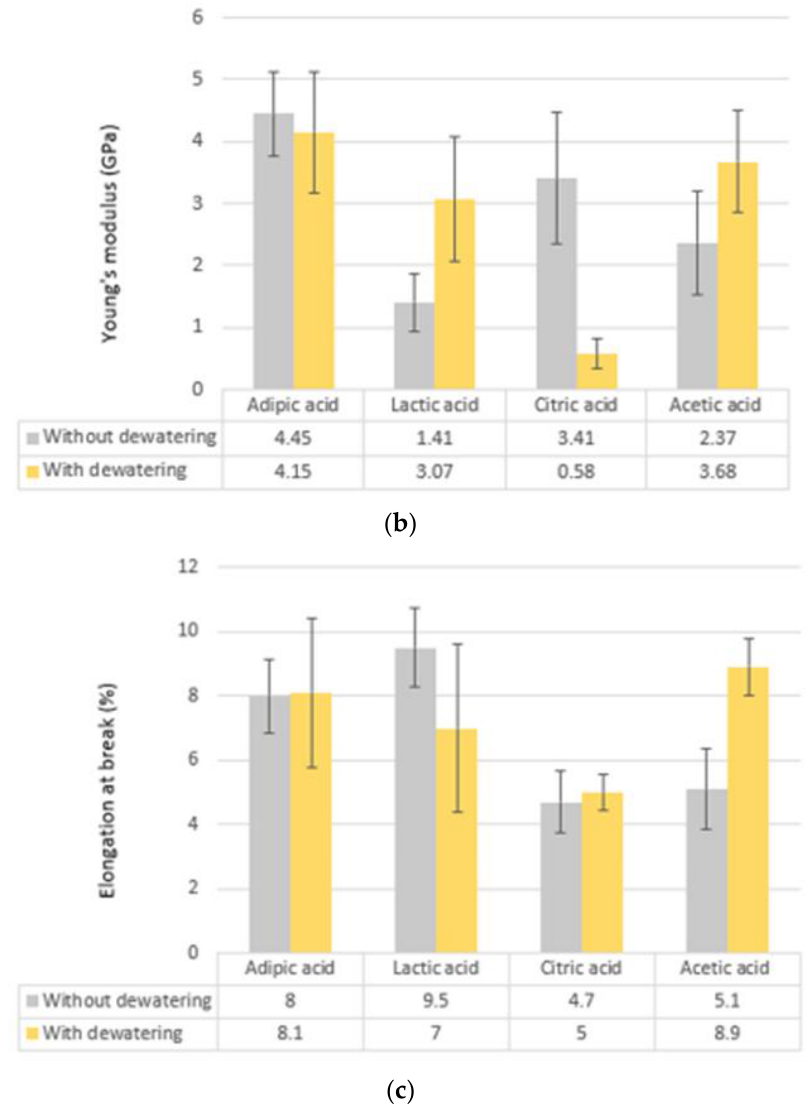
Figure 3. Mechanical properties of wet spun monofilaments coagulated in (1:1) 10% solution of NaOH and EtOH bath as the best coagulation bath: ( a ) tensile strength; ( b ) Young’s modulus; and ( c ) Elongation at break.